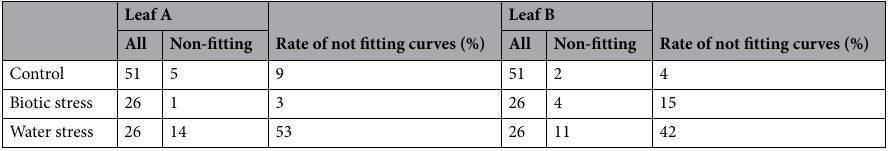
Table 8. Summary of the goodness-of-fit of exponential regression model.